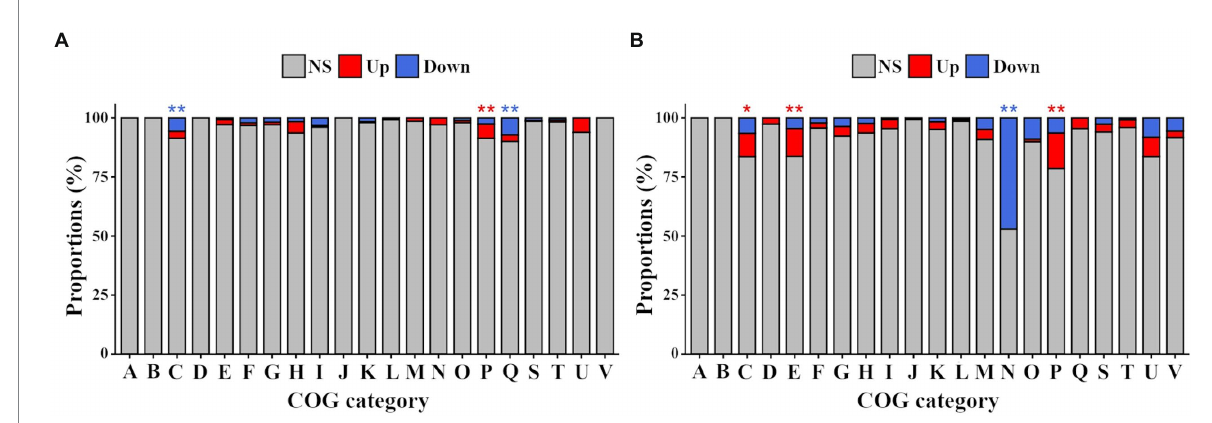
FIGURE 9 COG distribution of Arthrobacter sp. Helios DEGs found under simulated desiccation and control conditions. (A) Proportion of DEGs in each COG category when PEG10 condition was compared against control condition PEG0. (B) Proportion of DEGs in each COG category when PEG35 condition was compared against PEG0 condition. The proportions of non-significant (gray), upregulated (red) and downregulated (blue) genes are shown. A: RNA processing and modification; B: Chromatin structure and dynamics; C: Energy production and conversion; D: Cell cycle control, cell division, chromosome partitioning; E: Amino acid transport and metabolism; F: Nucleotide transport and metabolism; G: Carbohydrate transport and metabolism; H: Coenzyme transport and metabolism; I: Lipid transport and metabolism; J: Translation, ribosomal structure and metabolism; K: Transcription; L: Replication, recombination and repair; M: Cell wall/membrane/envelop biogenesis; N: Cell motility; O: Post- translational modification, protein turnover, chaperones; P: Inorganic ion transport and metabolism; Q: Secondary metabolites biosynthesis, transport and catabolism; R: General function prediction only; S: Function unknown; T: Signal transduction mechanisms; U: Intracellular trafficking, secretion and vesicular transport; V: Defense mechanisms. A hypergeometric test was performed to check whether genes were significantly overrepresented in each category (*p.adjust < 0.05; **p.adjust <